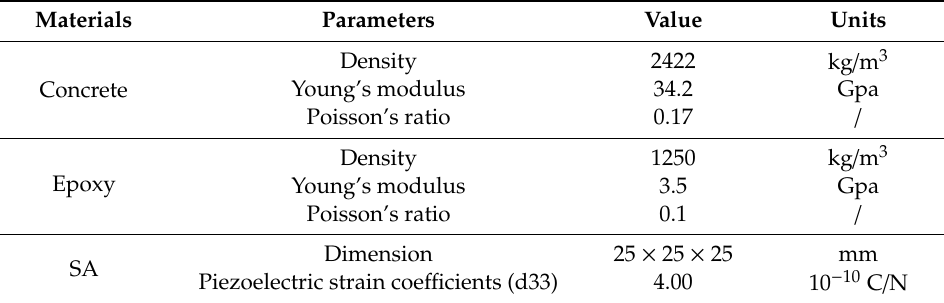
Table 1. Material properties of concrete, epoxy and smart aggregate (SA).